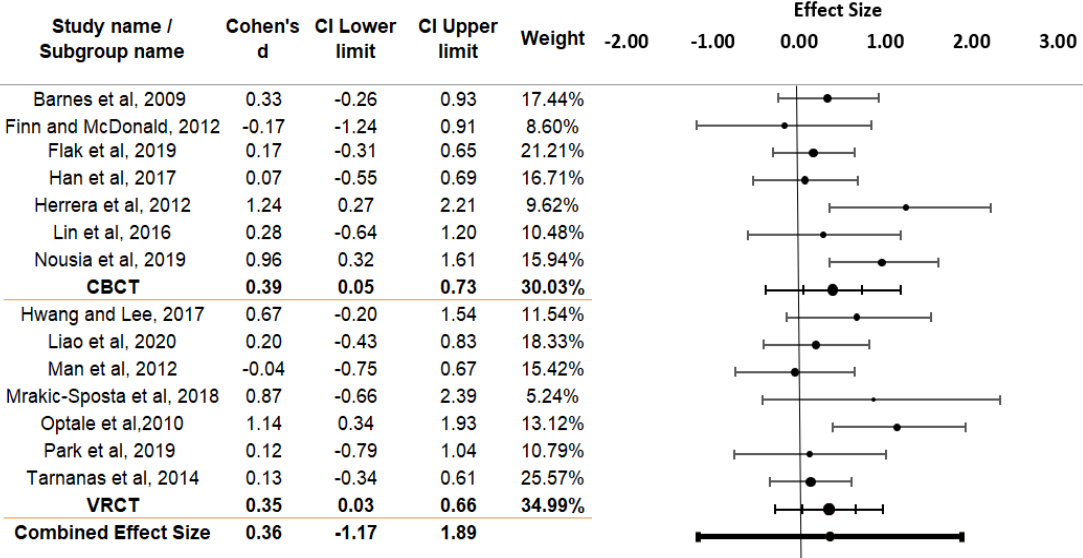
Figure 1. Forest plot of global cognitive function (GCF).